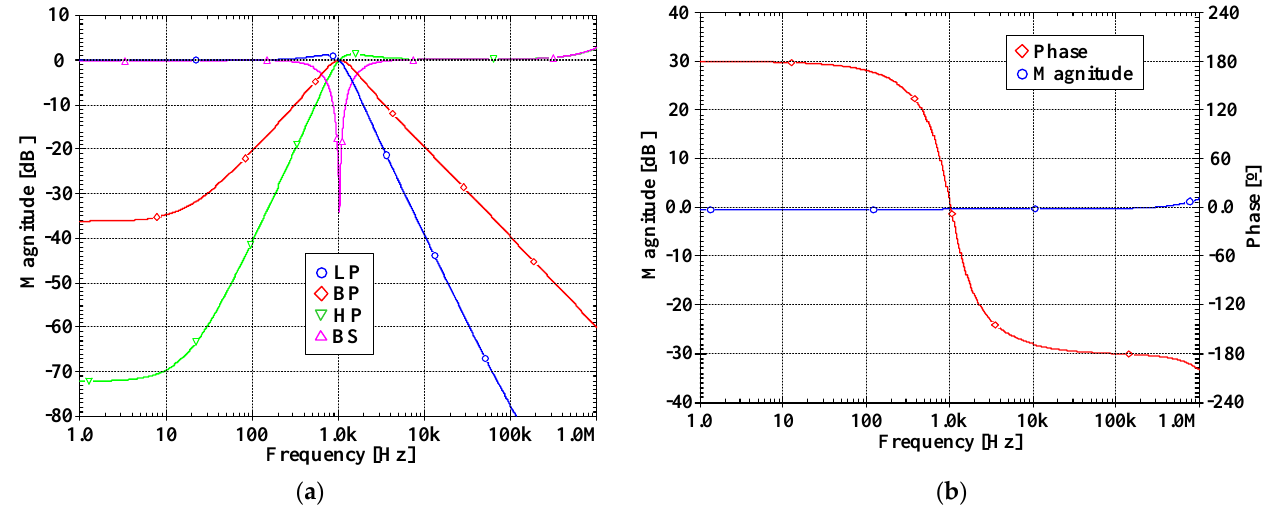
Figure 8. The simulated frequency responses of the CM filter: ( a ) LP, BP, HP, BS filters; ( b ) AP filter.